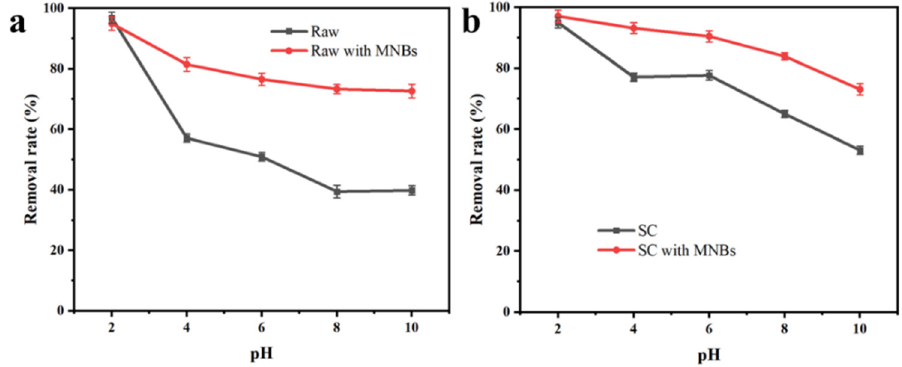
Figure 2. Influence of pH value on adsorption of CR ( a ) dye by raw coal and SC ( b ) with and without bubbles.